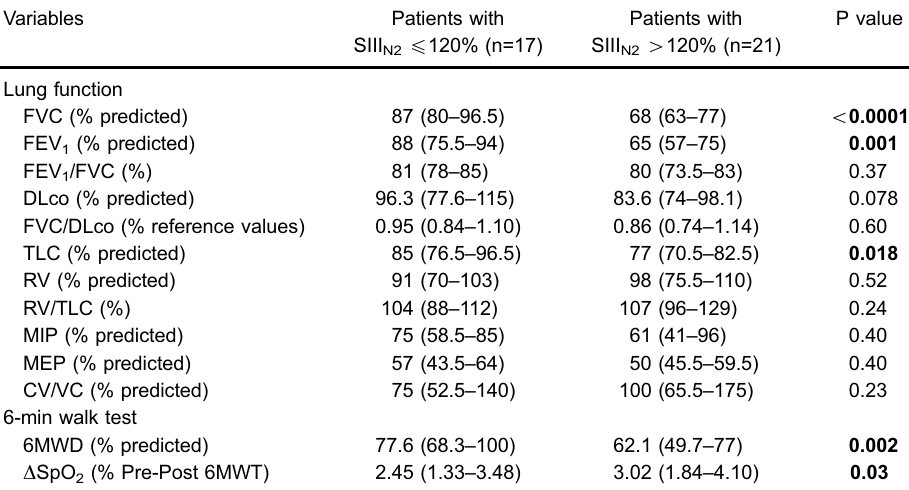
Table 2. Lung function and functional capacity data according to phase III slope of the nitrogen single- breath washout test.